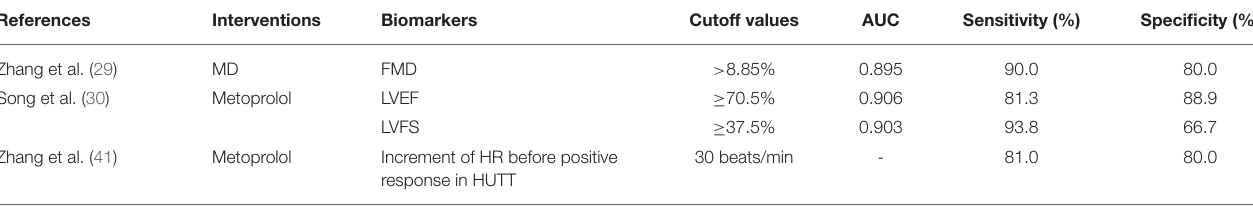
TABLE 1 | Predictors of therapeutic efficacy of pediatric VVS.